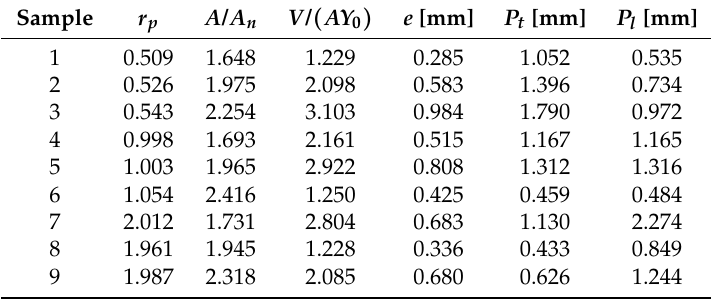
Table 2. Design parameters and geometric characteristics of the ESR patterned samples manufactured by laser etching technique: The characteristics of the samples have been defined according to the Taguchi method and the target levels in Table